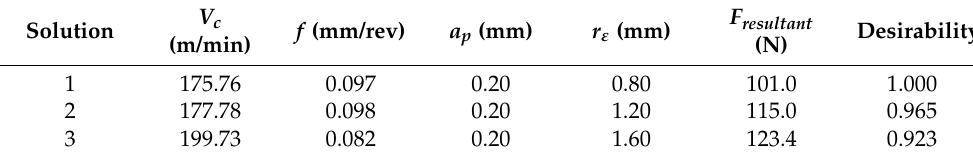
Table 7. Optimization procedure solutions.